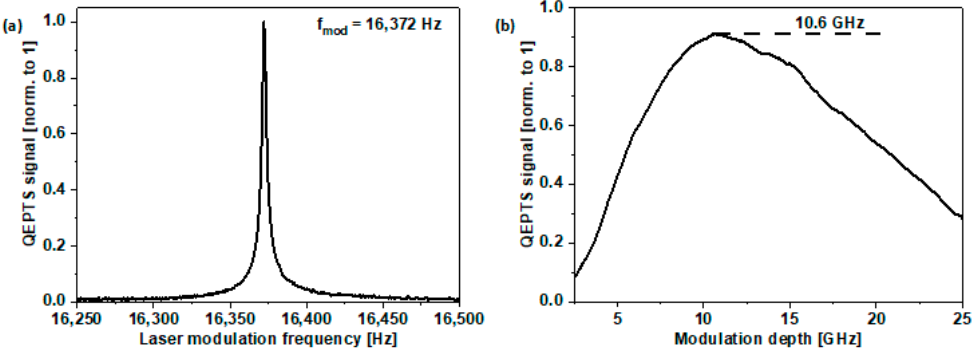
Figure 5. ( a ) Characterization of the QTF frequency responsivity. ( b ) QEPTS signal amplitude registered for different values of sinewave modulation depth. Measurements were performed with ARHCF filled with 2000 ppmv of CH 4 and f mod = 16.372 kHz.